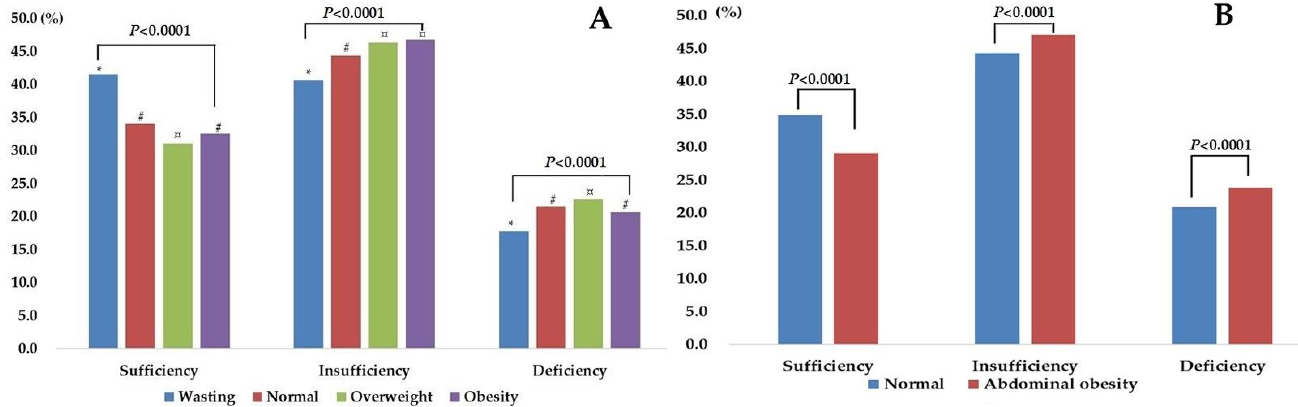
Figure 2. The vitamin D status in different growth level ( A ): *, #, ¤ refers to significant difference between groups; ( B ), normal status versus abdominal obesity.